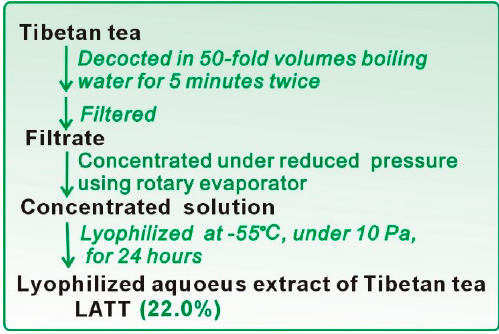
Figure 6. Preparation of LATT .